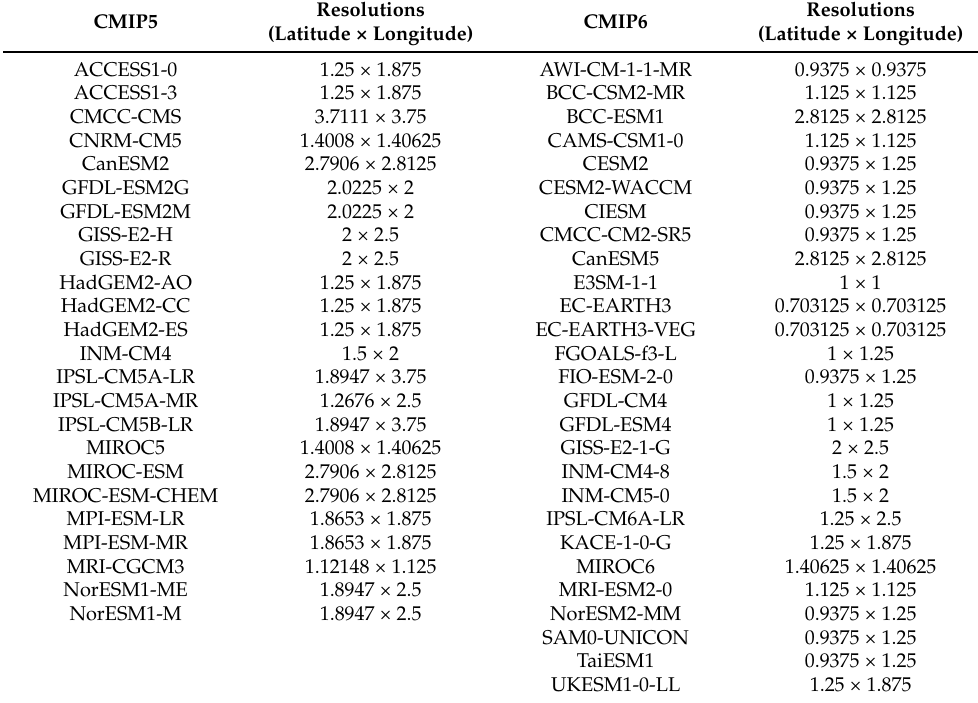
Table 1. The CMIP5 and CMIP6 models used and their horizontal resolutions.